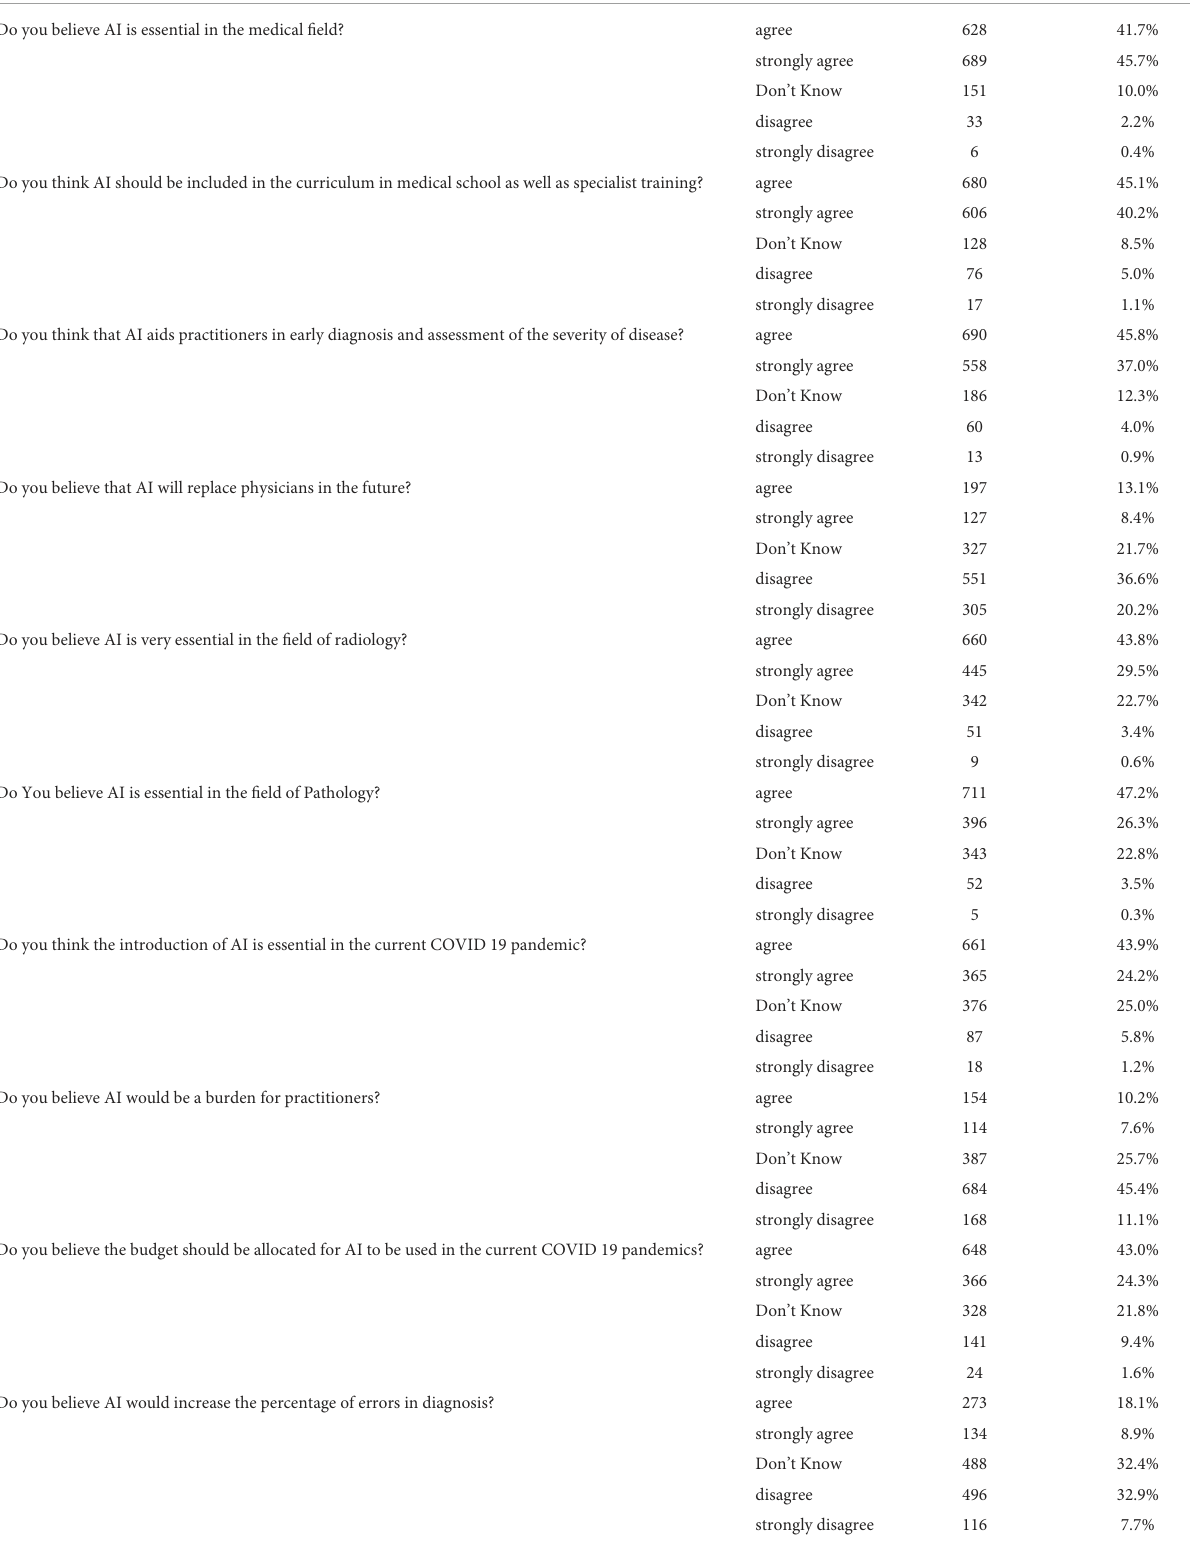
TABLE 6 Descriptive statistics for attitude toward artificial